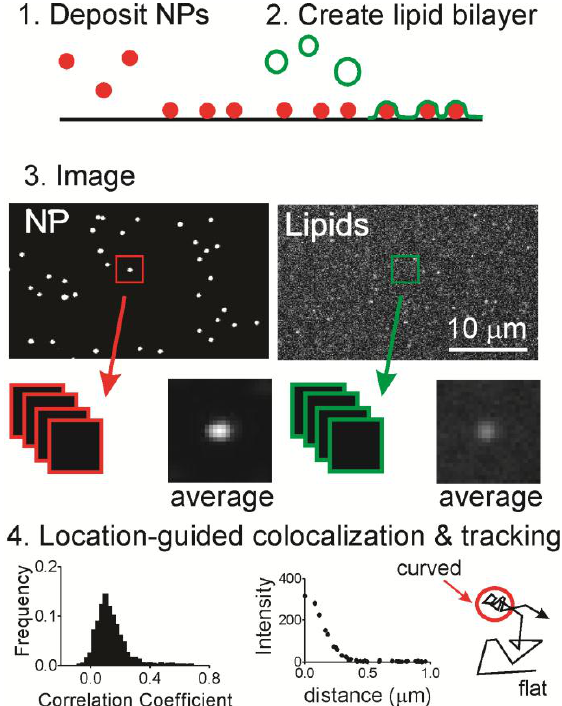
Figure 1. The general scheme of the experiment and analysis. (Step 1 ) Fluorescent NPs are deposited on a clean glass surface followed by (Step 2 ) incubation with liposomes for the preparation of a supported lipid bilayer; (Step 3 ) fluorescence microscopy is performed and images of NPs and fluorescently labeled lipids are sequentially obtained at the same location. NP positions are located and both images are cropped at these positions to give pairs of images; and (Step 4 ) the Pearson’s correlation coefficient is calculated for each pair of images, the average plot of intensity as a distance from the center pixel (termed a “radial plot”), and single particle tracking is performed on the two-color data (described left to right).